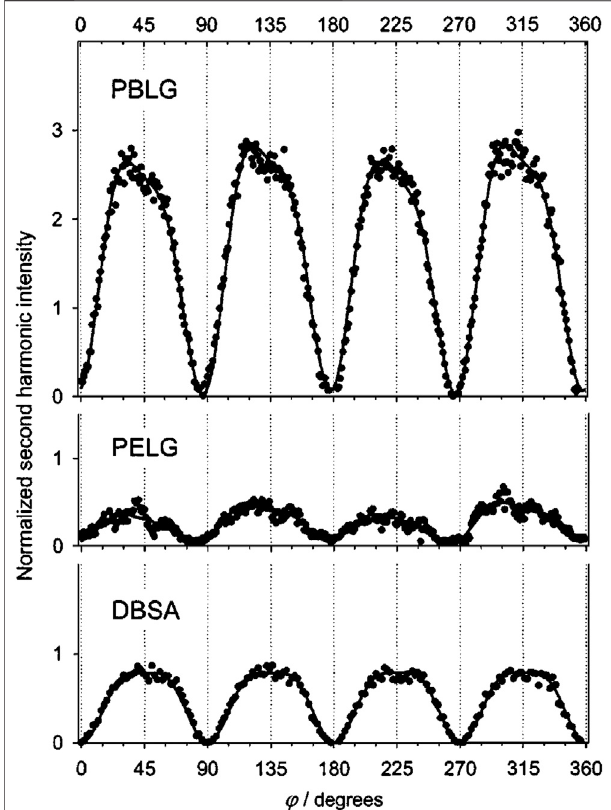
FIGURE 9 | Rotation traces I 2 ω ( φ ) for the polypeptides PBLG and PELG and for the achiral surfactant DBSA adsorbed at the air/water interface. The solid lines are fi ts of the data to Eq. (8). Note that the traces for the chiral interfaces PBLG and PELG are asymmetric about φ (cid:2) 180 ° , and the trace for the achiral interface DBSA is symmetric. The fi gure and caption have been adapted with permission from Mitchell et al., (2005), Copyright © 2005 AIP